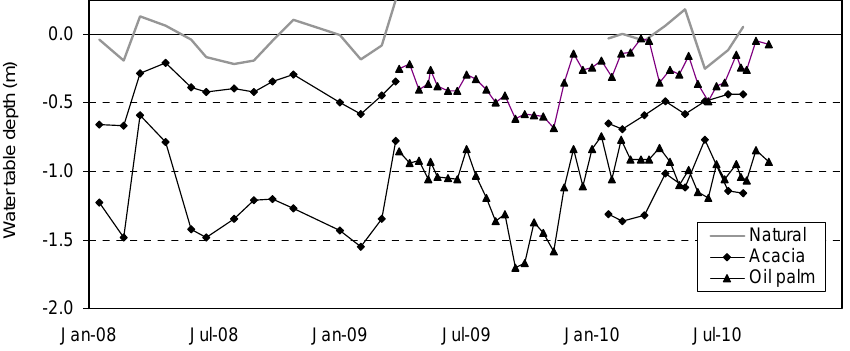
Fig. 8. Time series of water table depth as measured at some selected individual locations in the studied Acacia and oil palm plantations, and in nearby natural forest at 2 km from the Acacia plantation. In both plantation types, the records nearest the lower and upper 10-percentile average water levels are shown.